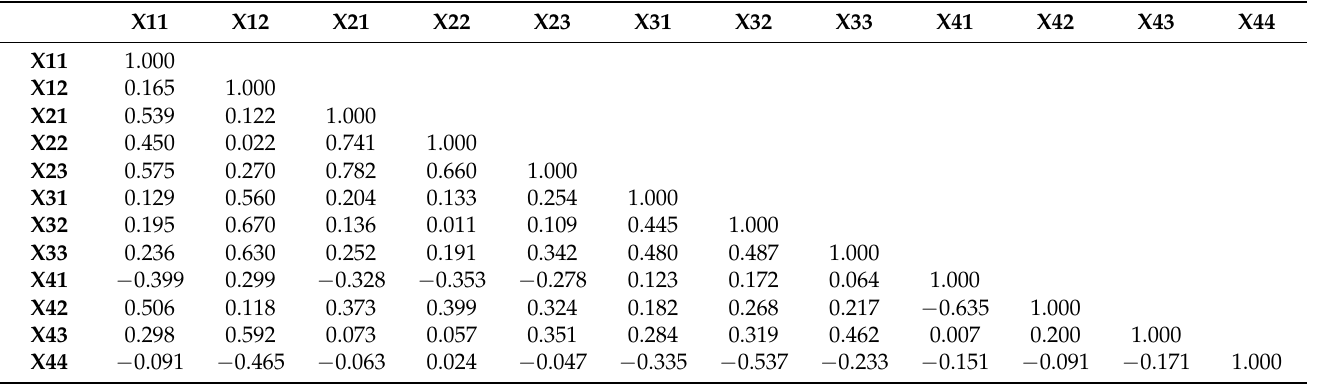
Table 2. Correlations of variables in